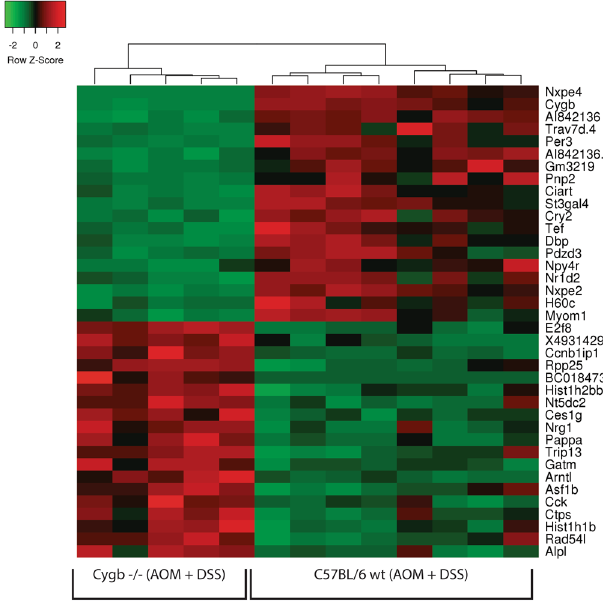
Figure 5. A heatmap depicting the relative expression of the top list of genes (rows) that are either highest expressed (red color) in the wild type mice or in the Cygb − / − mice during AOM/DSS-induced colitis. Gene symbols are shown to the right. Each column represents an individual